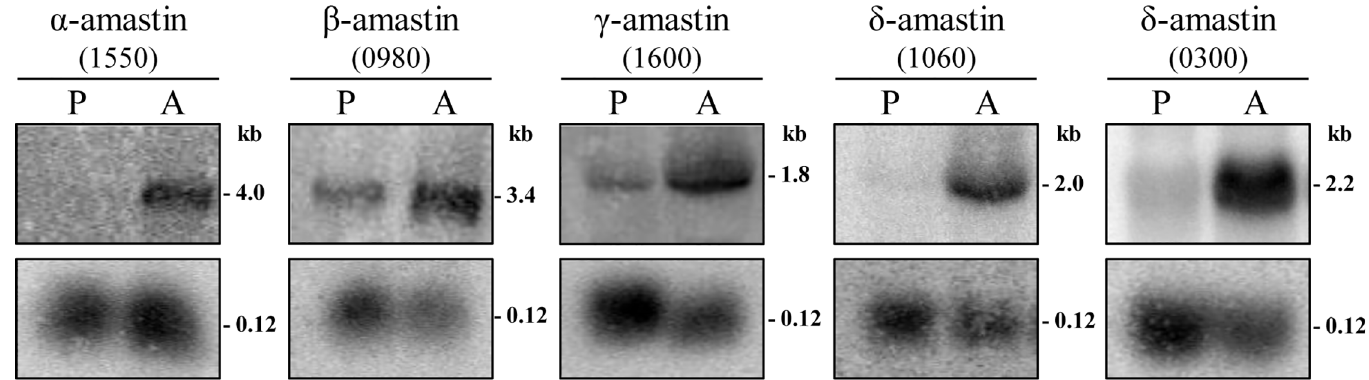
Fig 4. Differential expression of amastin mRNA during the L . braziliensis life cycle. Total RNA (10 μ g/lane), extrated from promatigote (P) and axenic amastigote (A) forms were separated by electrophoresis, transfered to nylon membranes and probed with the 32 P-labelled sequences corresponding to an α - amastin (LbM.28.1550), β -amastin (LbM.30.0980), γ -amastin (LbrM.24.1600) and two δ -amastins (LbM.08.0300 and LbrM.20.1060). Bottom panels show hybridization of the same membranes with a fragment of the 5S rRNA.